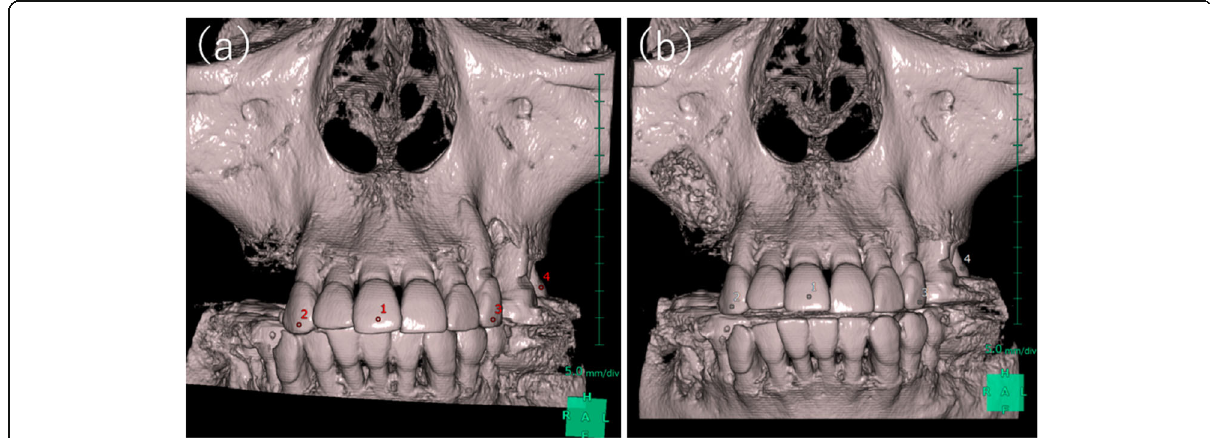
Fig. 2 “ Manual alignment ” was performed using residual teeth as reference points. a Preoperative CBCT data. b Postoperative CBCT